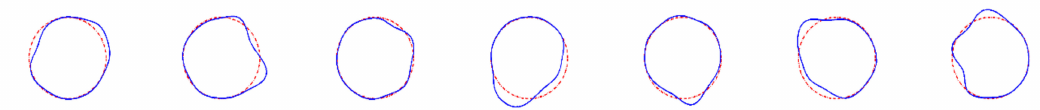
Figure 10. Forced response of the planet ring at different times in a period, T , of rotating speed at ω = 1 (dash line = original position; solid line = forced